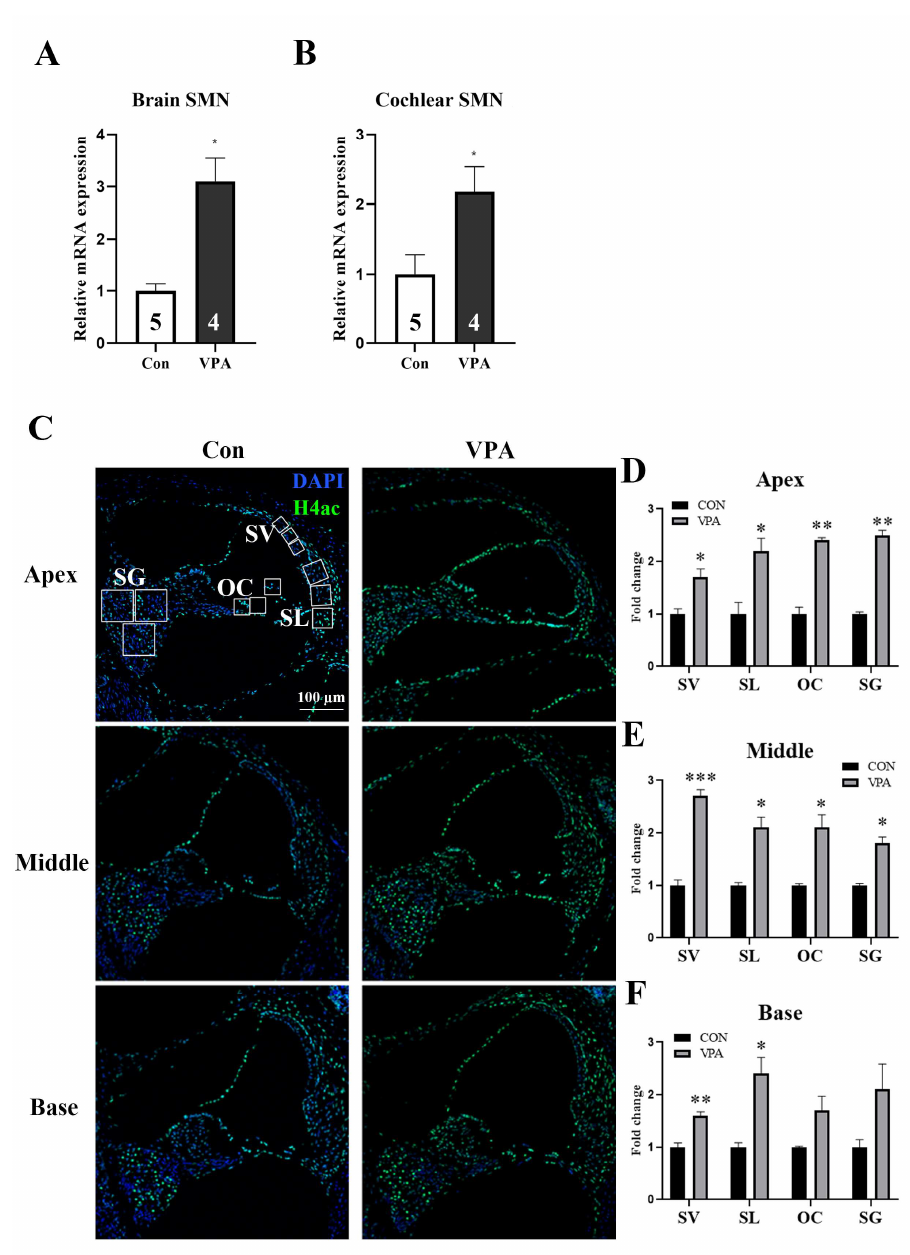
Figure 2. VPA increases SMN and histone H4 acetylation in the cochlea. ( A ) VPA treatment increased SMN mRNA levels in the brain. * p < 0.05, numerals in bar graphs are the numbers of samples. Error bars represent S.E.M. Con: control; VPA: valproic acid. ( B ) VPA treatment increased SMN mRNA levels in the cochlea. * p < 0.05, numerals in bar graphs are the numbers of samples. Error bars represent S.E.M. ( C ) VPA treatment enhanced histone H4 acetylation in the cochlear apex, middle, and base regions. Representative image of control mice in apex region. (SV: stria vascularis, SL: spiral ligament, OC: Organ of Corti, SG: spiral ganglion). ( D – F ) Quantification result of mice cochlea immunostaining. Whole-mount immunostaining of the cochlea with an antibody directed towards acetyl-histone H4 (H4ac, green) with DAPI. Cochlear apex, middle, and base H4ac intensity were calculated in the SV, SL, OC, and SG regions, each selected from the same three square areas. * p < 0.05, ** p < 0.01, *** p < 0.001. Error bars represent S.E.M.